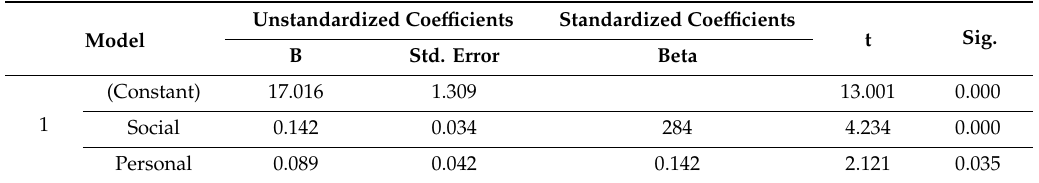
Table 4. Coe ffi cients of The structural model